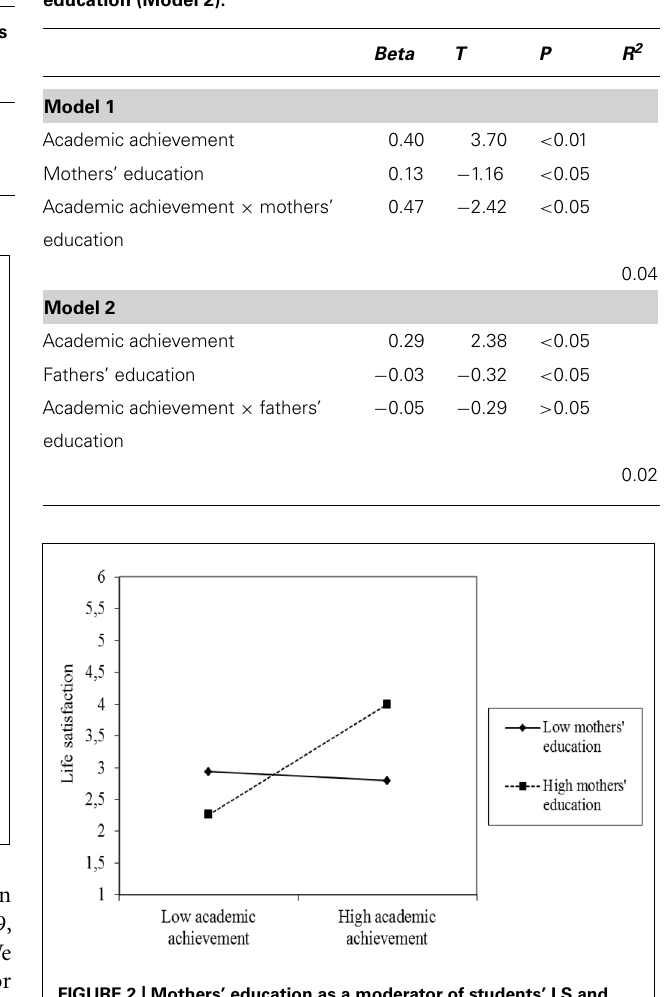
FIGURE 2 | Mothers’ education as a moderator of students’ LS and academic